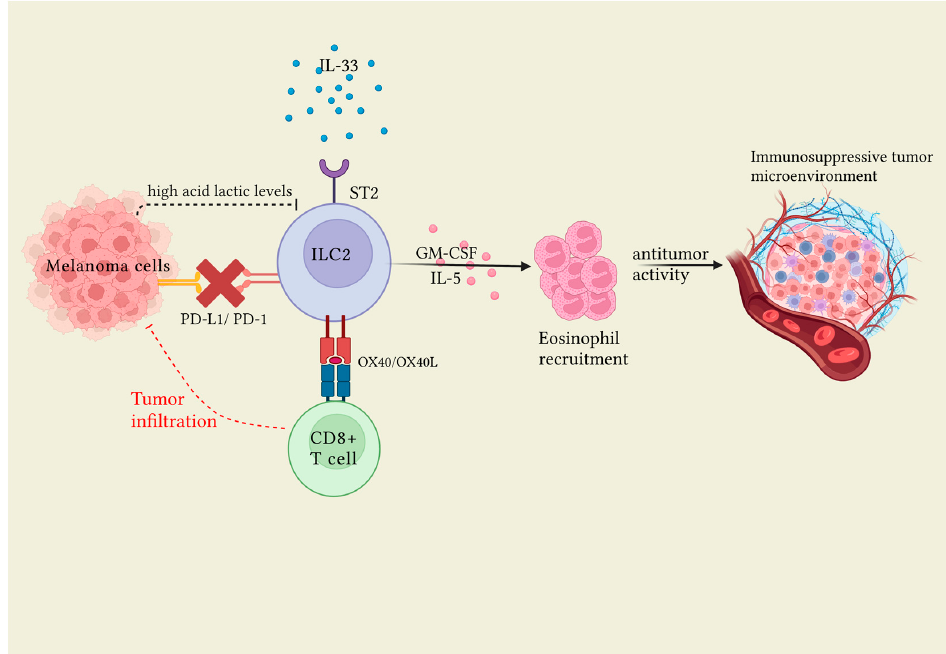
Figure 1. Following cell injury, IL-33 is released and induces ILC2 proliferation via the ST2 receptor expressed on the cell surface. ILC2s in turn, through GM-CSF and IL-5, induce the activation of eosinophils, which play an antitumor role. In order for ILC2s to be activated it is necessary that the PD1 link, expressed on ILC2s, with PD-L1 expressed on melanoma cells is inhibited. IL-33 induced the expression of OX40L and OX40 in ILC2s and CD8+ cells, respectively, thus enhancing antitumor effect through the infiltration of CD8+ cells into the tumor. Furthermore, high levels of lactic acid released from the tumor play a role in inhibiting ILC2 activity. Created with BioRender.com .